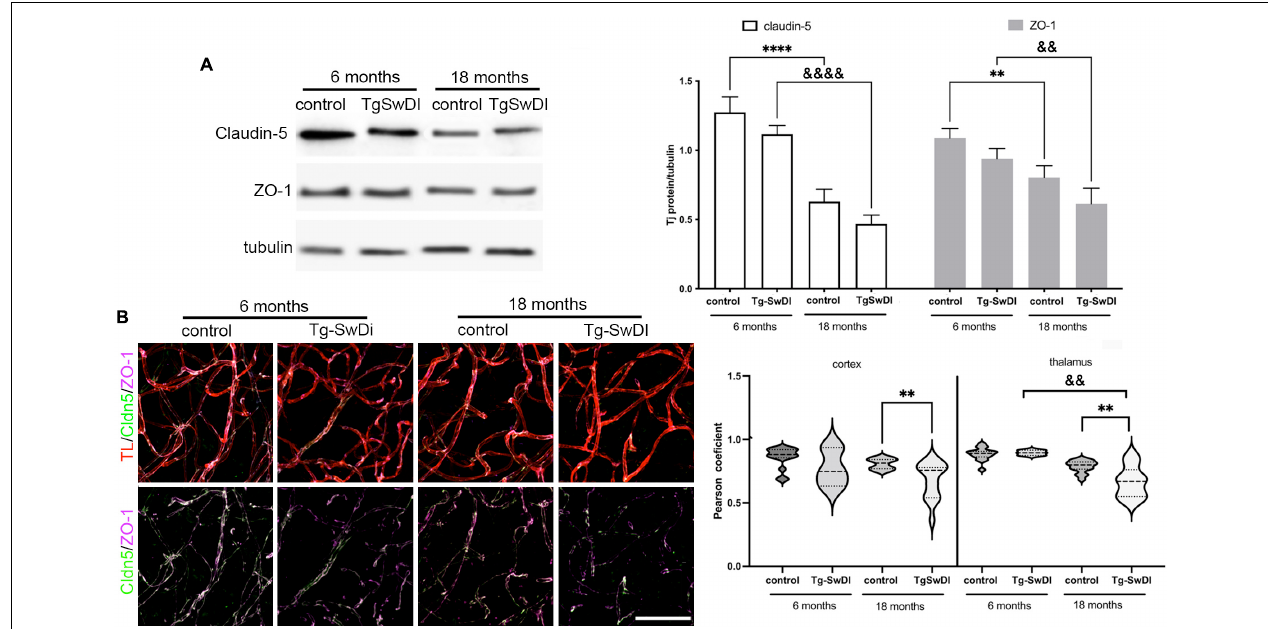
FIGURE 2 | (A) Western blot and semi-quantitative densitometric analysis of claudin-5 and ZO-1 protein expression in microvessels isolated from young Tg-SwDI (6 months) and old Tg-SwDI age (18 months) mice and corresponding age-matched control. Protein levels were normalized to tubulin. Notice the decreased expression of claudin-5 and ZO-1 in total protein expression in Tg-SwDi (18 months old) as well in aging mice (18 months old). Graph represents means ± SD, n = 5; ∗∗ p < 0.01, && p < 0.01 and ∗∗∗ p < 0.001, &&& p < 0.001 comparing genotypes of different ages. Western blotting image is one of five independent experiments. (B) Representative images of the maximum 3D projection of z-stack (400, 400, and 200 µ m) after immunofluorescence for tight junction proteins claudin-5 (green) and ZO-1 (Far red) in the cortex of young Tg-SwDi (6 months) and old Tg-SwDI age (18 months) mice and corresponding age-matched wildtype controls. Blood vessels were labeled with Tomato lectin (TL; red). Scale bar 50 µ m. Arrow indicates the colocalization site of claudin-5 and ZO-1. Semiquantitative analysis of the colocalization of claudin-5 and ZO-1 in microvessels as a measure of claudin-5/ZO-1 interaction by calculating a Pearson correlation coefficient in cortex and thalamus in all experimental groups. The Tg-SwDI (18 months) showed a decreased level of the claudin-5 and ZO-1 colocalization compared with age-matched control in cortex and thalamus, as well as with young Tg-SwDI (6 months) in the thalamus. N = 3 mice per group and a total of 15 slides for both regions, ∗∗ p < 0.01 compared to control and && p < 0.01 compared to the same genotype. ****Comparing to control and &&&& comparing to same